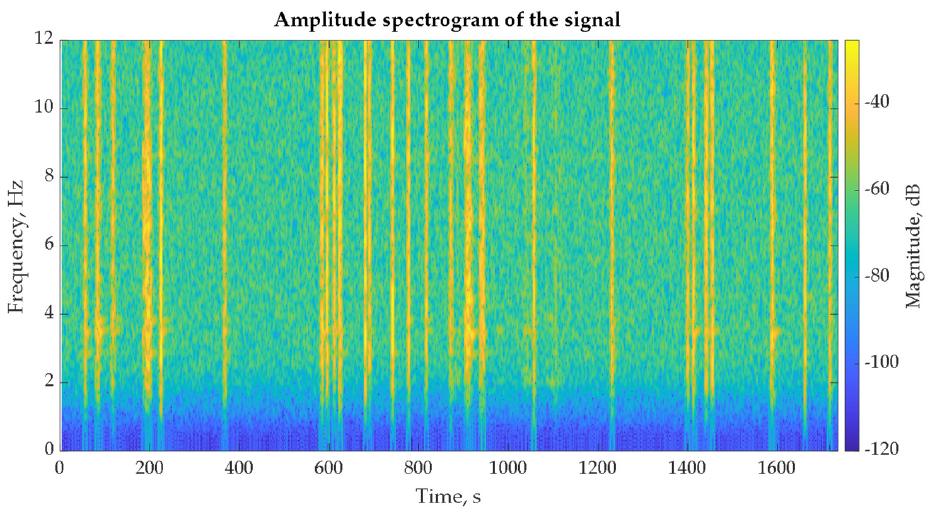
Figure 15. Short Time Fourier Spectrum of sensor 5 at vertical axis.